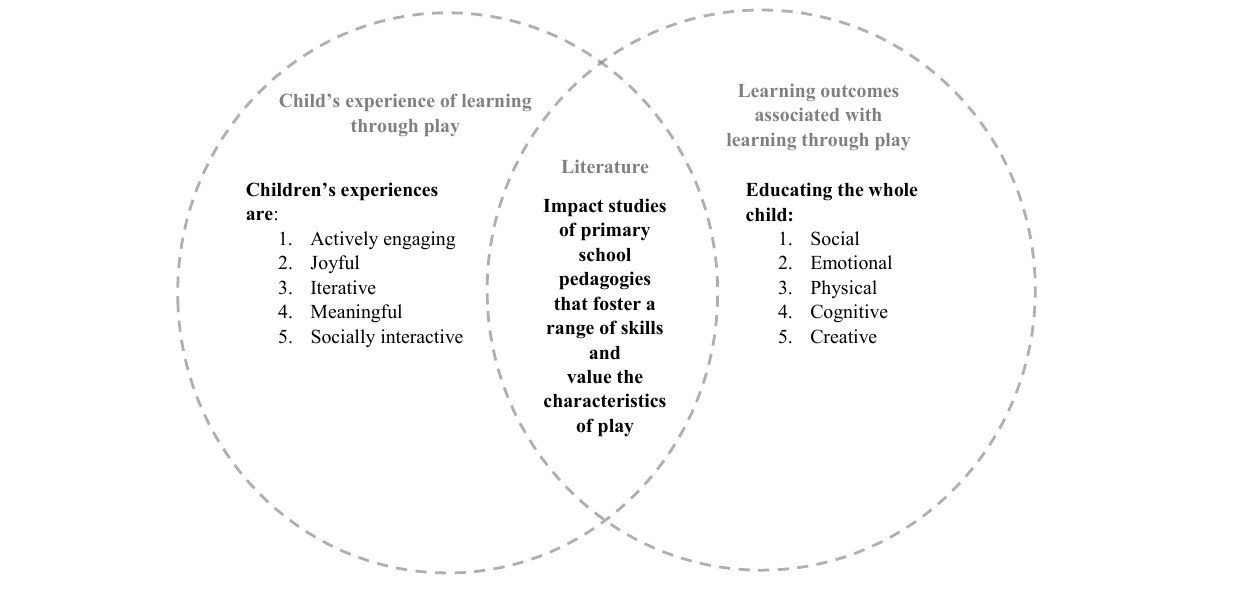
FIGURE 1 | Conceptualization of learning through play for literature analysis.